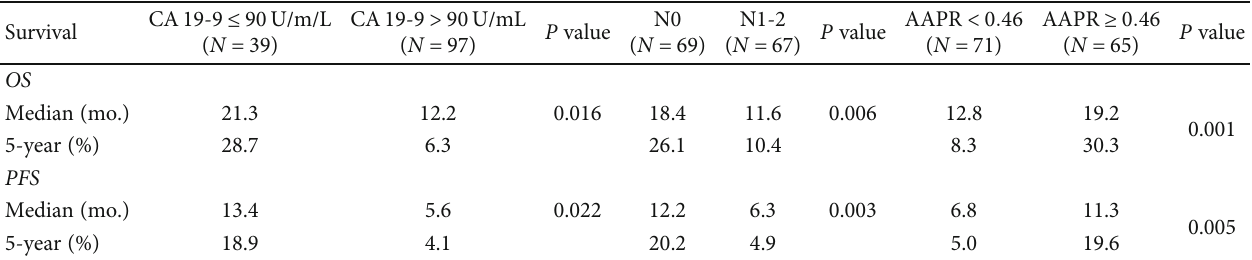
N1-2 nodal stage (4.2% versus 20.9% for N0), and L-AAPR